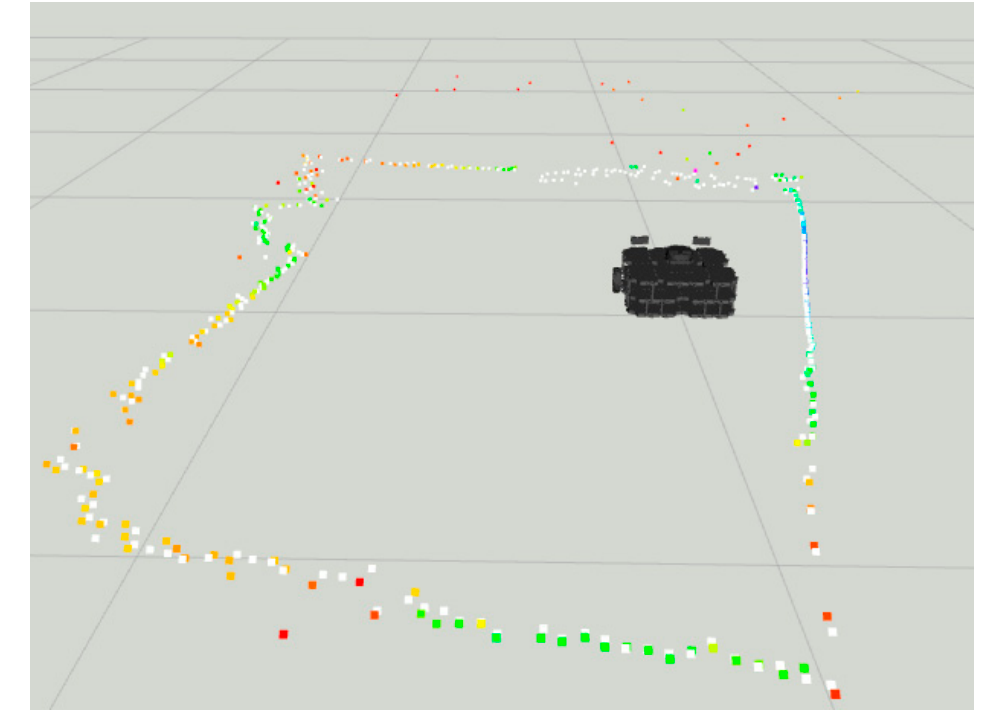
Figure 34. Pre and post fusion readings for LiDAR-Sonar-Camera fusion using bug mesh as main obstacle.